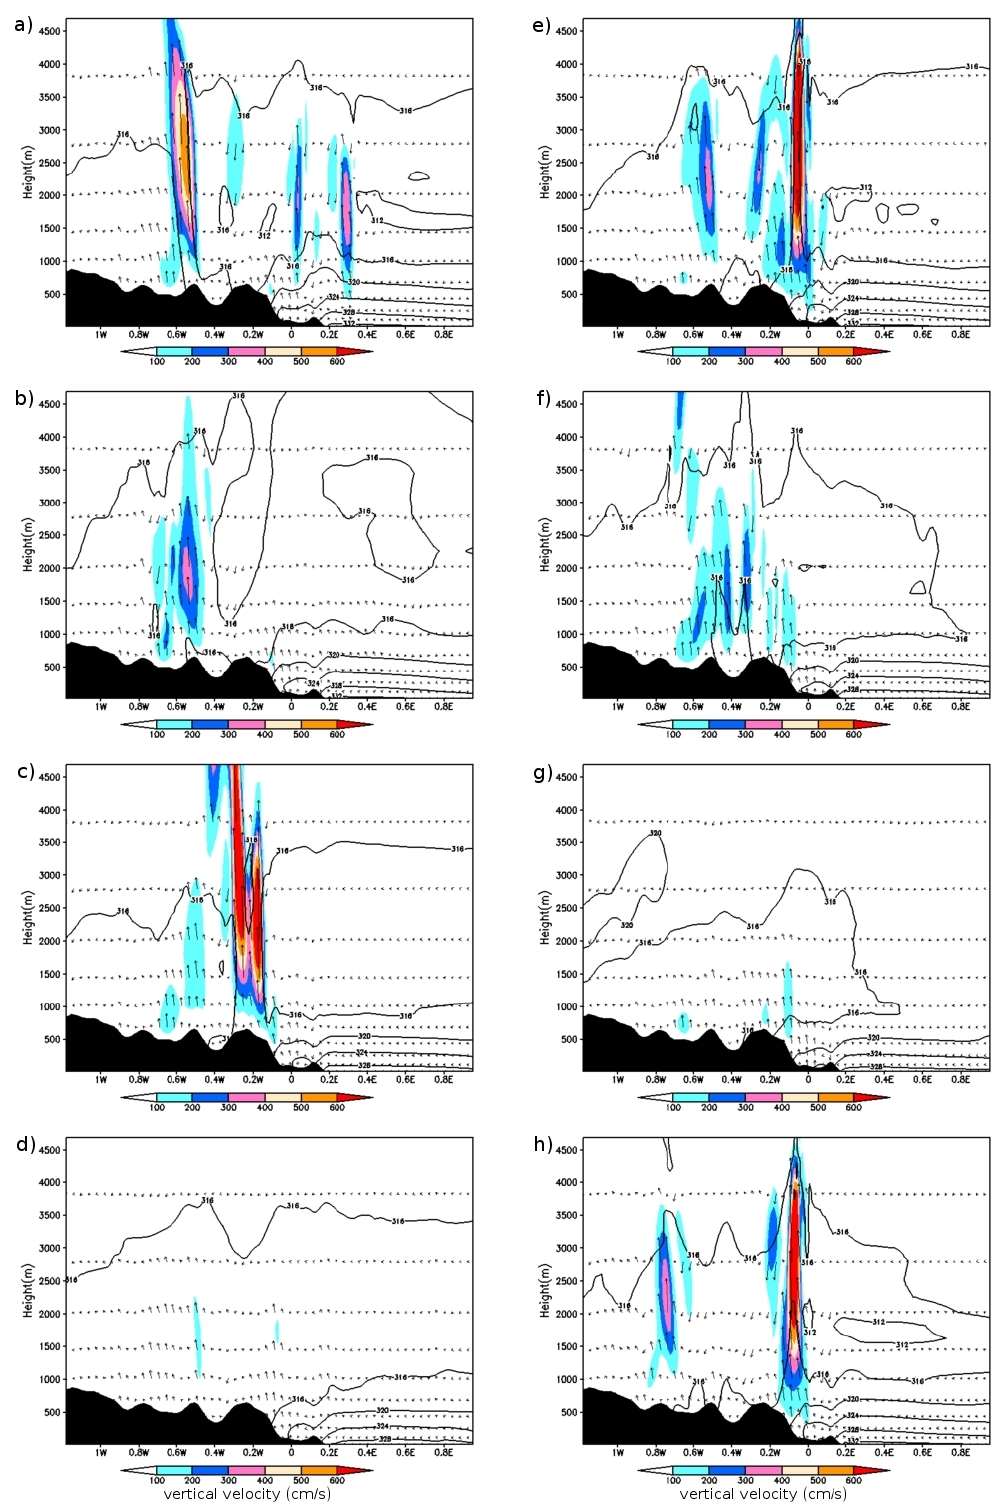
Fig. 12. Vertical cross section at 38.8 ◦ N RAMS equivalent potential temperature (K, contoured), vertical velocity (cm/s, shaded color) and wind vector (arrows) on 06:00UTC 12 October for (a) Kuo1, (b) Kuo2, (c) Kuo3, (d) Kuo4, (e) KF1, (f) KF2, (g) KF3 and (h)